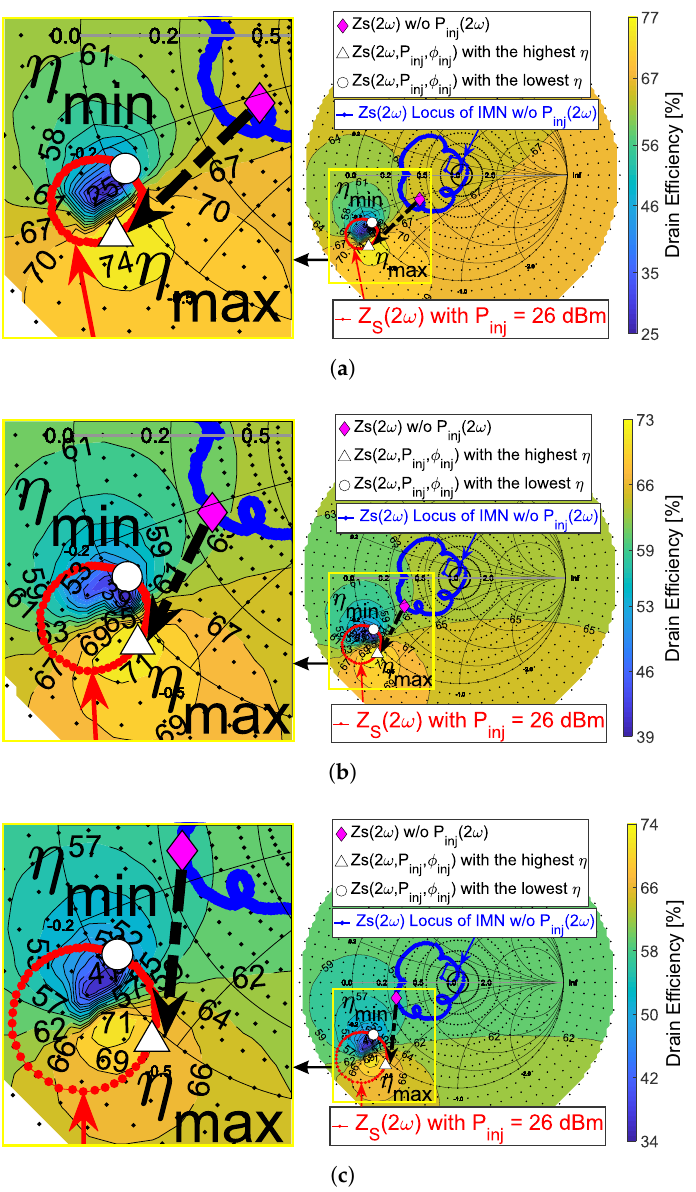
Figure 2. Simulated drain efficiency source-pull results of the second-harmonic source impedance Z S ( 2 ω ) with constant output power of 40.3 dBm when ( a ) ω = 1.9 GHz, ( b ) ω = 2 GHz, and ( c ) ω = 2.1 GHz. The blue line is the Z S ( 2 ω ) locus at the transistor’s gate package reference plane (PRP) without input second-harmonic injection. The rhombic markers in magenta indicate the Z S ( 2 ω ) of the final IMN at each frequency without input second-harmonic injection. The red dots give the location of the Z S ( 2 ω ) for the specified injected second-harmonic power when the phase of the input second-harmonic signal injection is varied from 0 to 2 π . The black dashed arrows indicate the optimal Z S ( 2 ω ) tuning realized by the second-harmonic